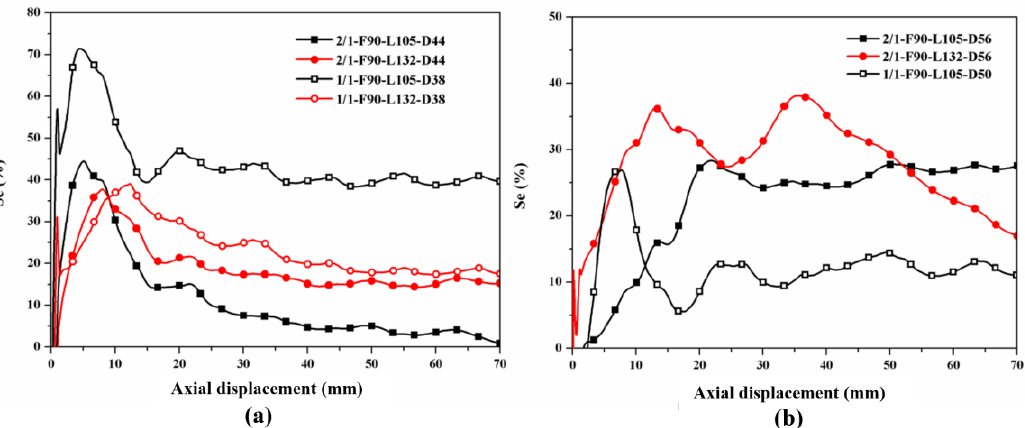
Figure 20. Comparison of hybrid effect ratio between the tubes: ( a ) specimens with large L / D ratio; ( b ) specimens with small L / D ratio.